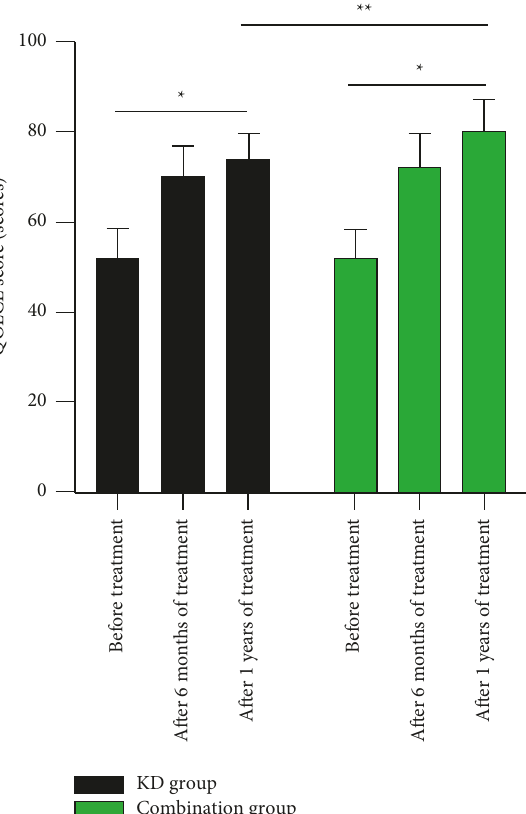
6: Quality of life scores between the two groups of children. ∗ Comparison between the same group before treatment and after 1 year of treatment, P < 0 . 05; ∗∗ comparison between groups after 1 year of treatment, P < 0 .